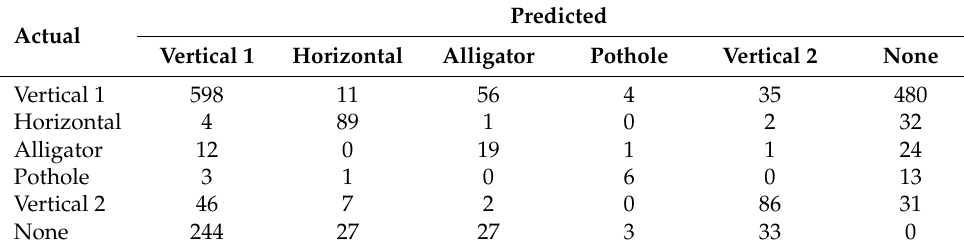
Table 4. Confusion matrix of Model 2.